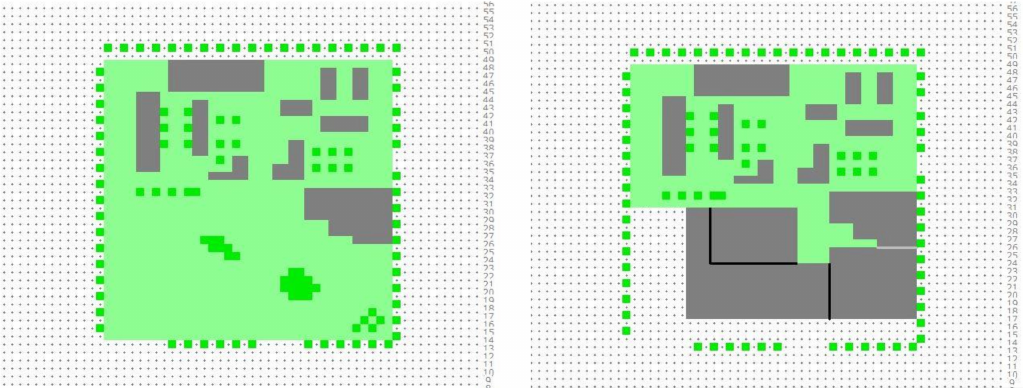
Figure 5. 2006 site morphology (left) and 2013 site morphology